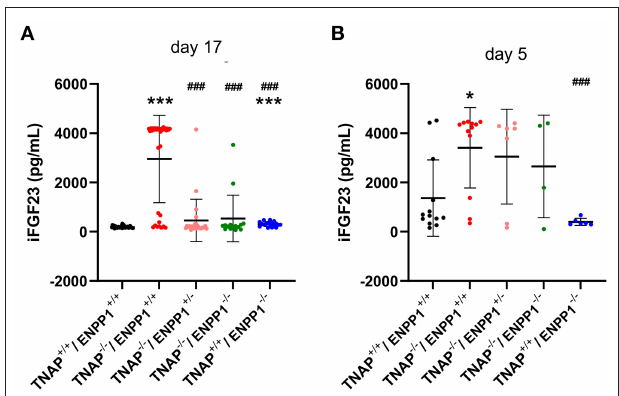
FIGURE 8 | Serum FGF23 levels in TNAP and ENPP1 deficient mice. Serum was isolated from postnatal day 17 (A) and postnatal day 5 (B) mice and assayed for intact FGF23 by ELISA. Food was withdrawn for 18h prior to day 17 serum isolation. No food was withdrawn for day 5 serum isolation. Results show increased FGF23 in the serum of TNAP + / + /ENPP1 − / − mice compared to TNAP + / + /ENPP1 + / + mice, but even greater levels are seen in the serum of TNAP − / − /ENPP1 + / + mice at day 17. At day 5, FGF23 levels are more variable in serum but TNAP − / − /ENPP1 + / + mice still show significantly greater FGF23 than serum from the serum of TNAP + / + /ENPP1 + / + mice. * p < 0.05 vs. TNAP + / + ENPP1 + / + mice, *** p < 0.005 vs. TNAP + / + /ENPP1 + / + mice, ### p < 0.005 vs. TNAP − / − /ENPP1 + / +